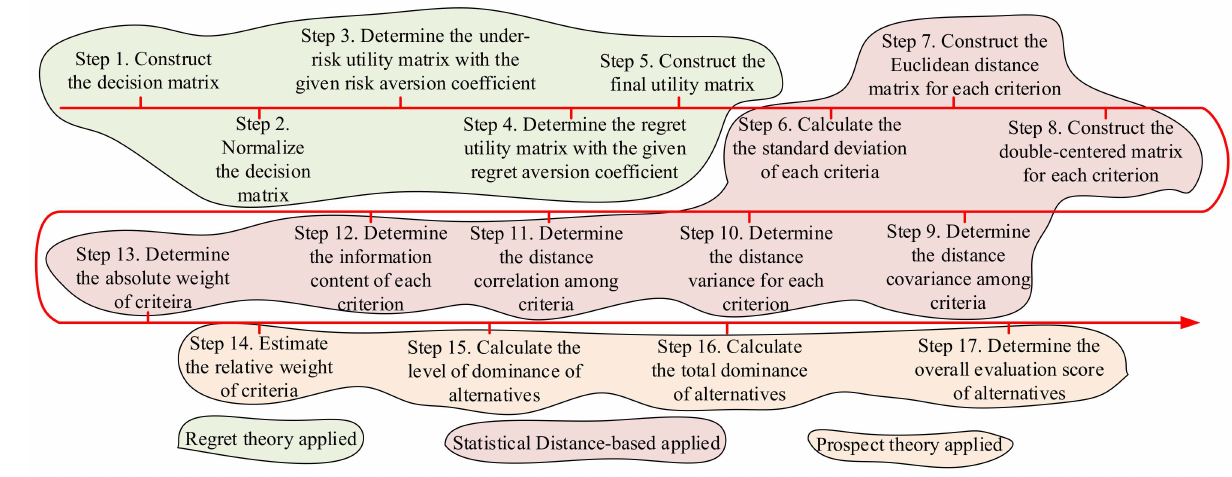
Figure 1. The proposed